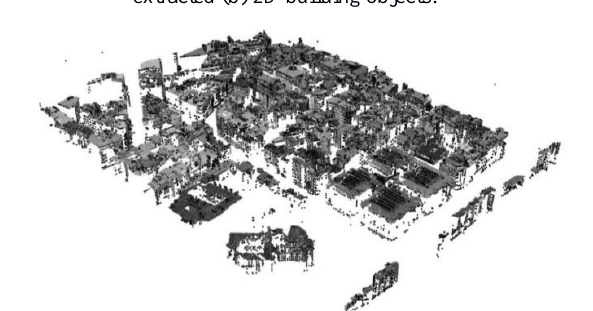
Figure 4. (a) Input multispectral image and automated extracted (b) 2D building objects.